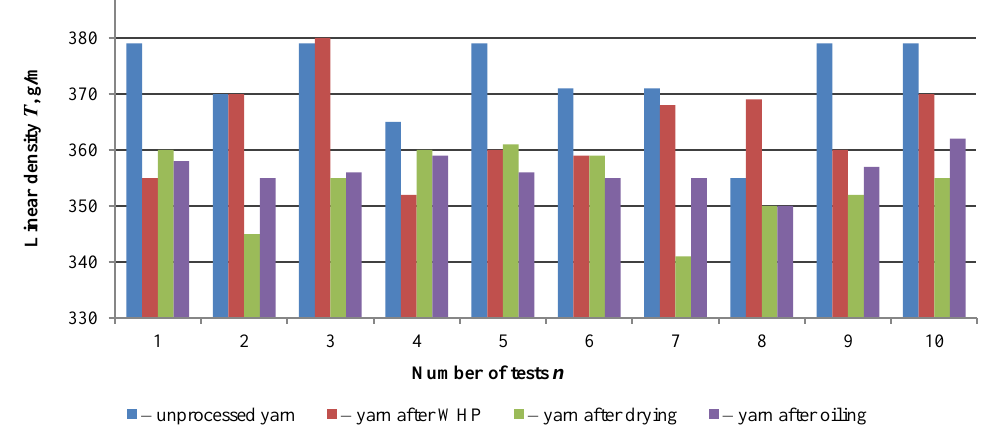
Fig. 6. The influence of WTO pure wool yarn on the surface density of the weave curly weave. The results of the research are clearly seen in the charts of distribution of the surface